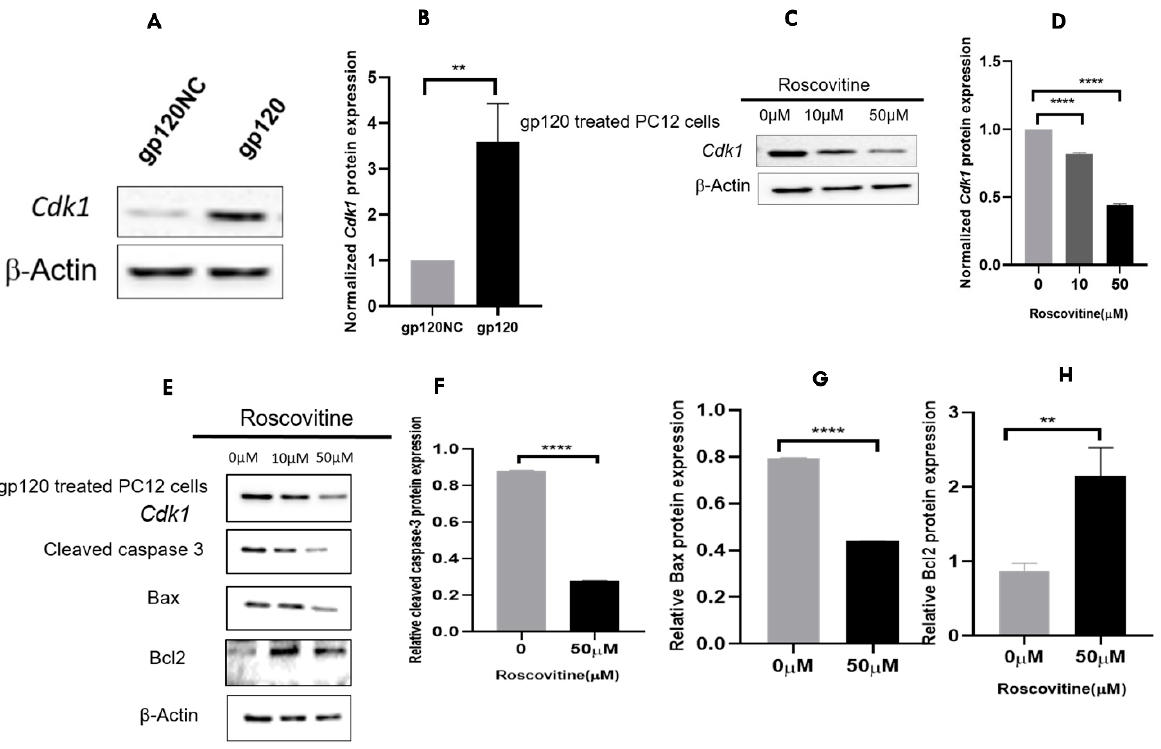
Figure 6. CDK1 in HIV-associated dementia. ( A ) The Uniform Manifold Approximation and Projec- tion plot (UMAP), ( B ) Volcano plot, and ( C ) Mean-difference plot. ( D ) indicates the p -value and the Log2FC of CDK1 in HIV-associated dementia against the normal control.